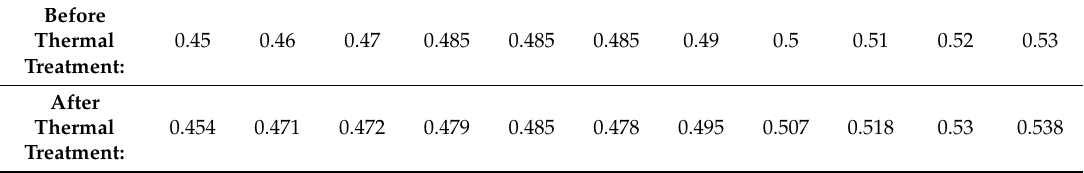
Table A1. Composition (molar fraction of TRIS) in NPG-TRIS mixtures determined by 1 H NMR.